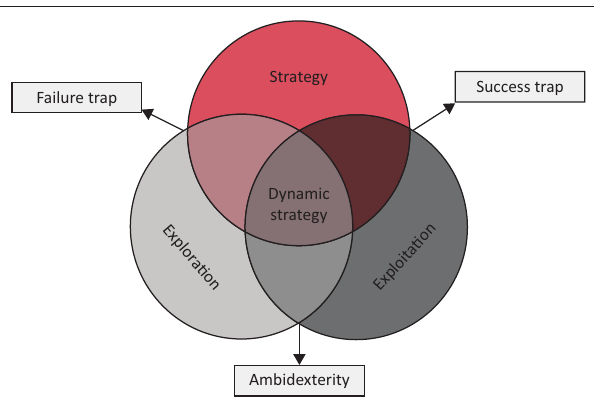
FIGURE 1: Exploration, exploitation and